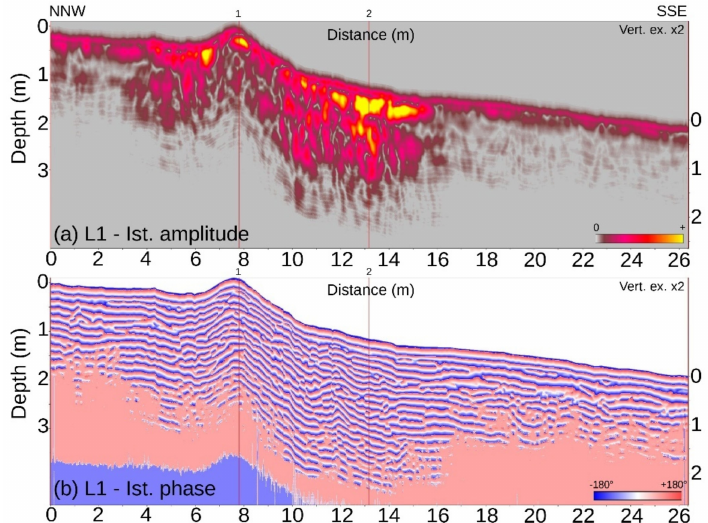
Figure 13. Instantaneous attributes of profile L1 of Figure 12; ( a ) instantaneous amplitude, displaying the only moderate reflectivity across the cololite C14, but a high reflective zone downhill at a closer distance in the first meter depth (12–15 m range); ( b ) instantaneous phase, enhancing the presence of a buried body of complex geometry corresponding to the reflective zone, as well as subparallel horizons with good continuity within the attenuated zone until the end of the